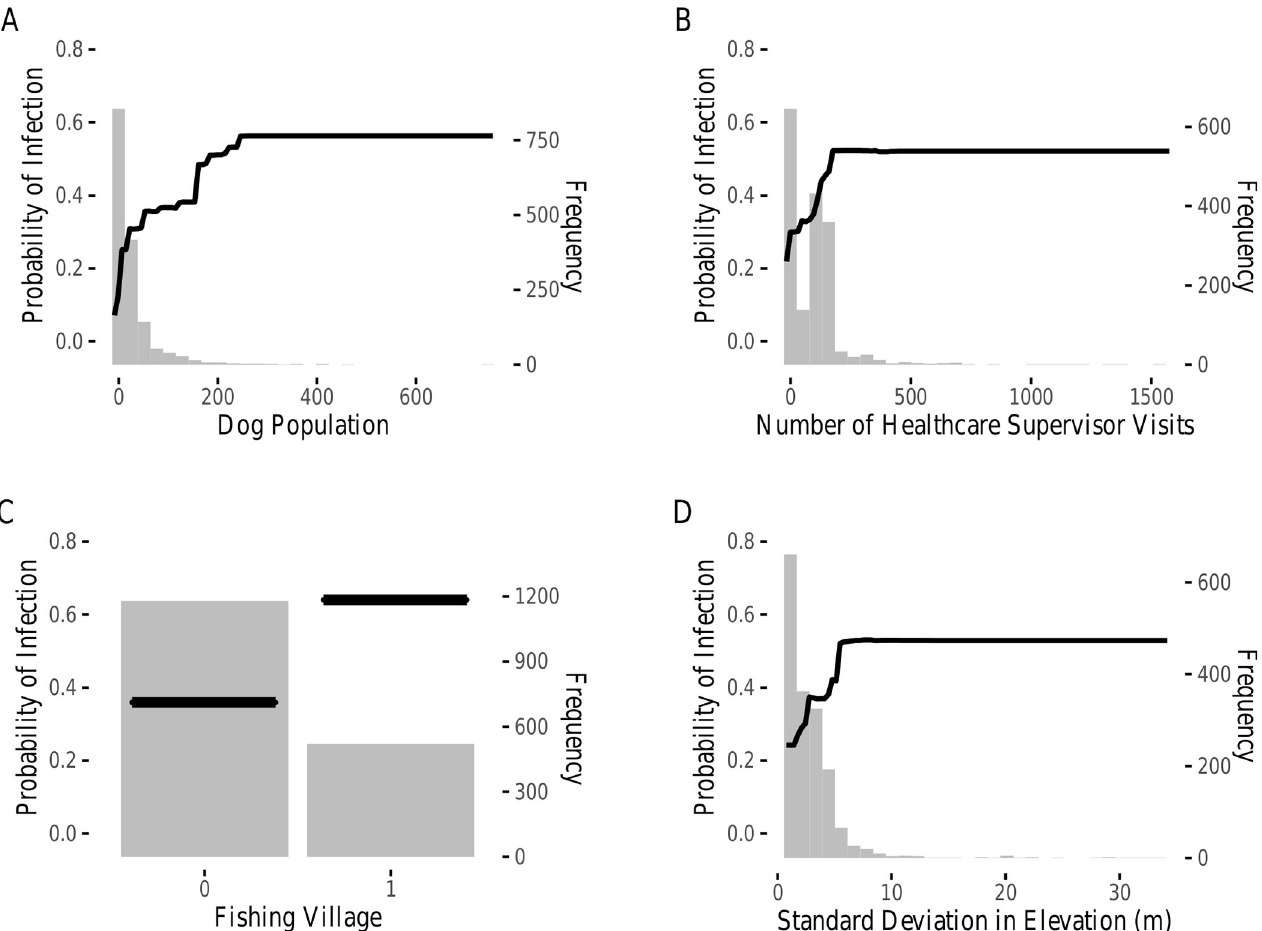
Fig 3. Village-level partial dependence plots. Partial dependence plots showing the effect of (a) dog population, (b) number of healthcare supervisor visits, (c) identity as a fishing village, and (d) standard deviation in elevation on probability of dog infection. Histograms represent the distribution of values for these covariates amongst all training